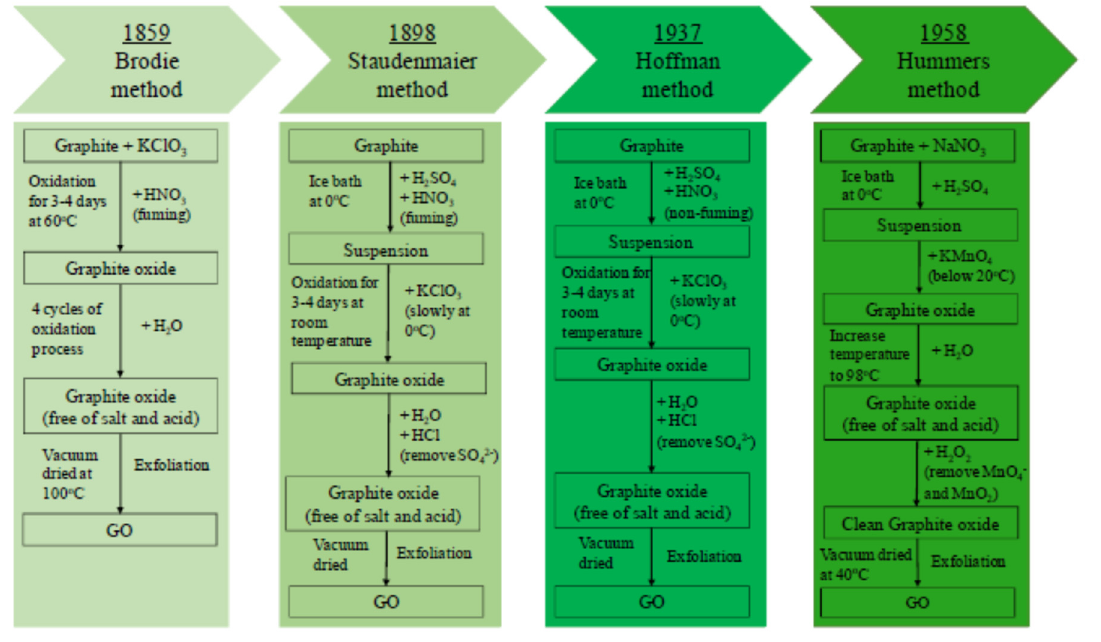
Figure 4. Synthesis routes of GO [53].